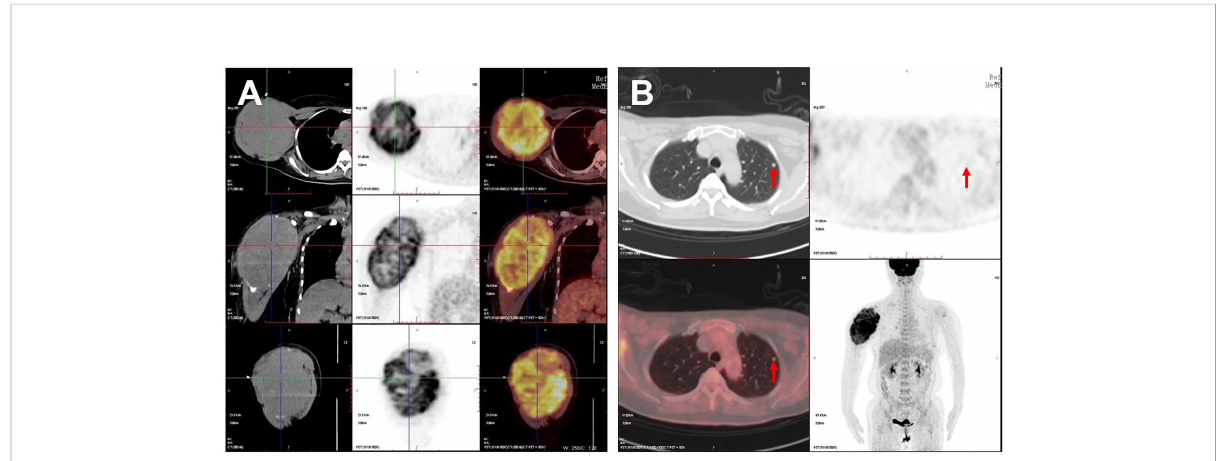
FIGURE 1 PET/CT images of the patient. Increased 18F-FDG metabolism showed in (A) the large right humerus (130 × 115 × 174 mm) on the cross, sagittal, and coronal sections and in (B) the left lung (6.5 × 6.0 mm); red arrows indicate the lung